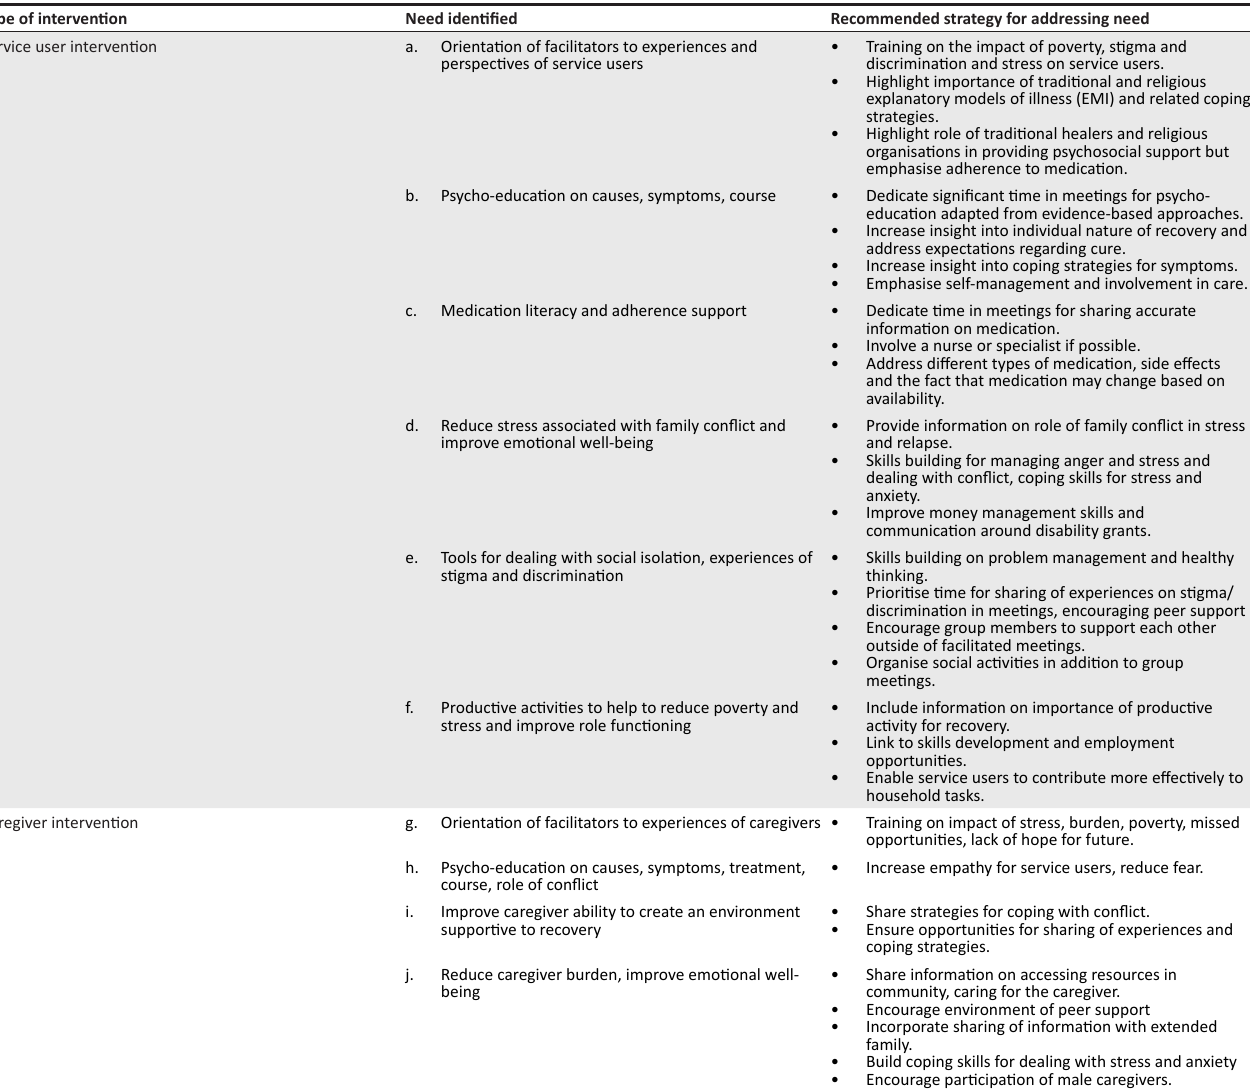
TABLE 2: Recommended elements of a contextually appropriate group psychosocial intervention for service users with schizophrenia and caregivers in the North West Province, South Africa. Type of